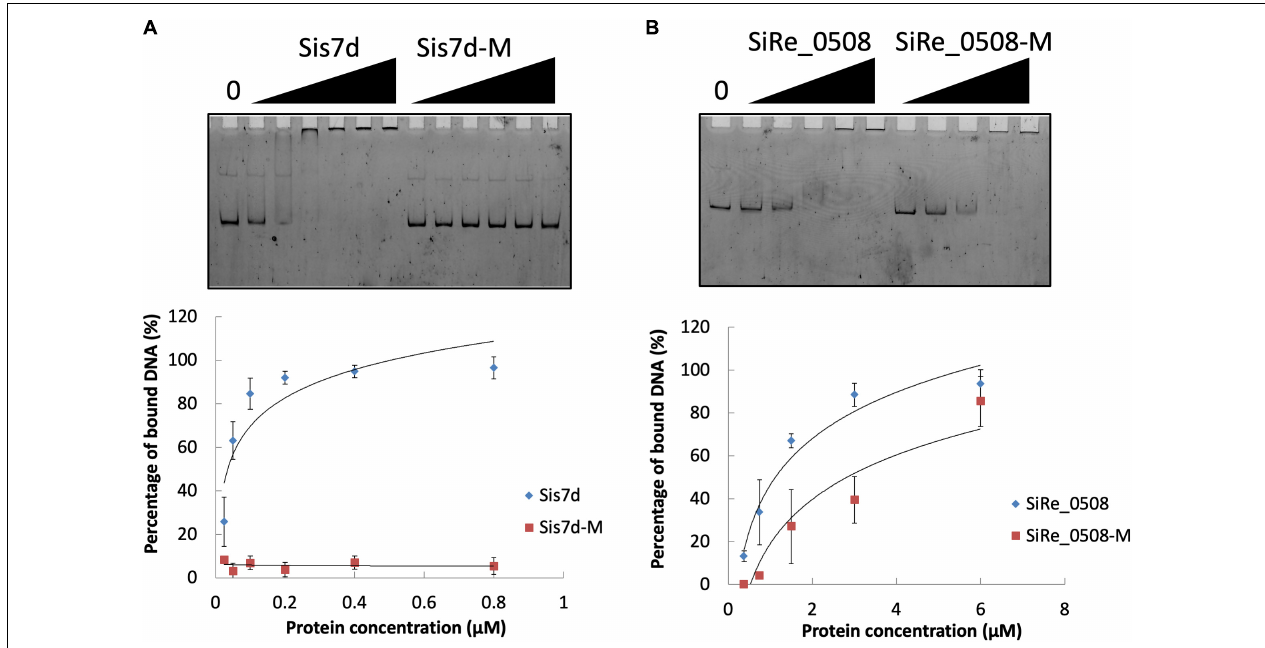
FIGURE 6 | DNA binding ability of chromosome remodeling proteins and their phosphor-mimic mutants. (A) EMSA of Sis7d and its mutants Sis7d-T41E/S47E. The reaction was performed at 37 ◦ C for 30 min and analyzed in 8% native PAGE (see section “Materials and Methods”). Protein concentration of 0.025, 0.05, 0.1, 0.2, 0.4, and 0.8 µ M was used. (B) EMSA of SiRe_0508 and SiRe_0508-Y263E/Y266E. Protein concentration of 0.38, 0.75, 1.5, 3, and 6 µ M was used. Representative gels are shown. The quantitative data was obtained from at least three independent experiments. Error bars indicate standard